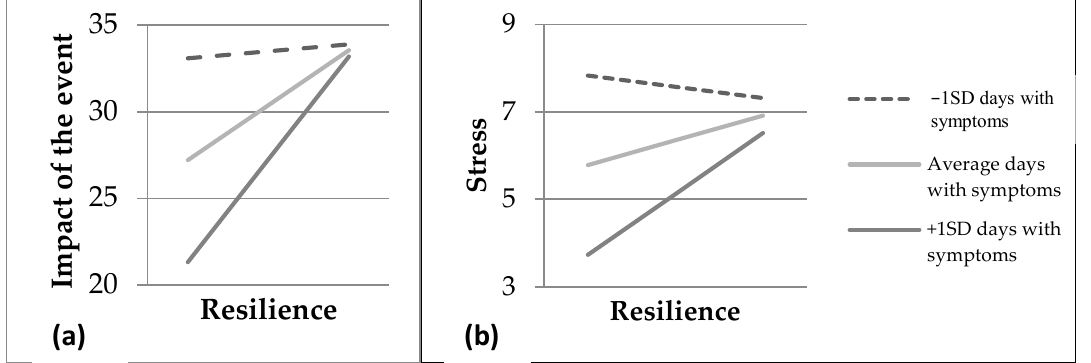
Figure 2. ( a ) Moderation of resilience on the traumatic impact of the event as a function of the number of days with COVID-19; ( b ) moderation of resilience on stress as a function of the number of days with COVID-19.